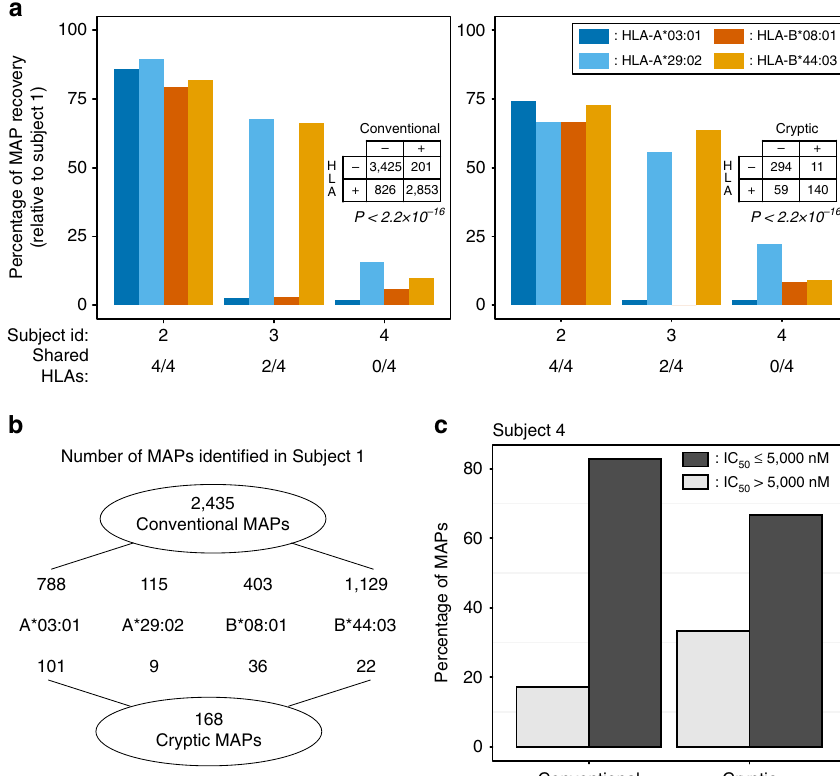
Figure 2 | Detection of Crypt. and Conv. MAPs is HLA-dependent. ( a ) Relationship between MAP detection and HLA genotype. We sequenced MAPs on B-LCLs from three subjects who shared four, two or no HLA alleles with subject 1. We then determined the number of Conv. (left) and Crypt. (right) MAPs found in subject 1 that were shared by subjects 2–4. Each bar represents one HLA allotype. A detailed schematic of the analysis can be found in Supplementary Fig. 4. MAP detection in subjects 2–4 correlated with presence of the HLA allotype presenting the MAPs in subject 1: P o 2.2 (cid:2) 10 (cid:3) 16 for Conv. and Crypt. MAPs (two-sided Fisher’s exact test). ( b ) Schematic detailing of the numbers of Conv. and Crypt. MAPs identified in subject 1 for the considered HLA alleles. ( c ) Most MAPs detected in subject 4 are promiscuous binders. Overall, 168 Conv. and 9 Crypt. MAPs detected in subject 1 were also detected in subject 4, even though the two subjects did not share any HLA alleles. Using NetMHCcons, we computed the predicted binding affinity (IC 50 ) of those MAPs for the four HLA-A and -B allotypes of subject 4, and we kept the lowest of the four IC 50 values (corresponding to the highest MHC- binding affinity). The bar chart depicts the percentage of Conv. and Crypt. MAPs having an IC 50 r or 4 5,000nM. Peptides with an IC 50 r 5,000nM